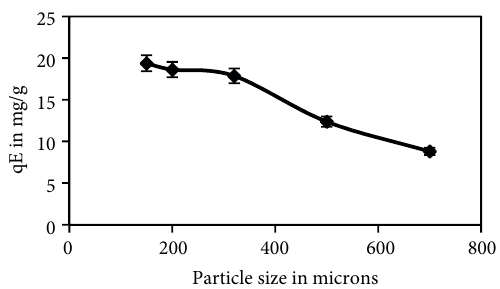
Fig. 5. Effect of particle size at 20% by weight acid concentration, impregnation ratio 1:8, temperature 60 °C and stirring speed 350